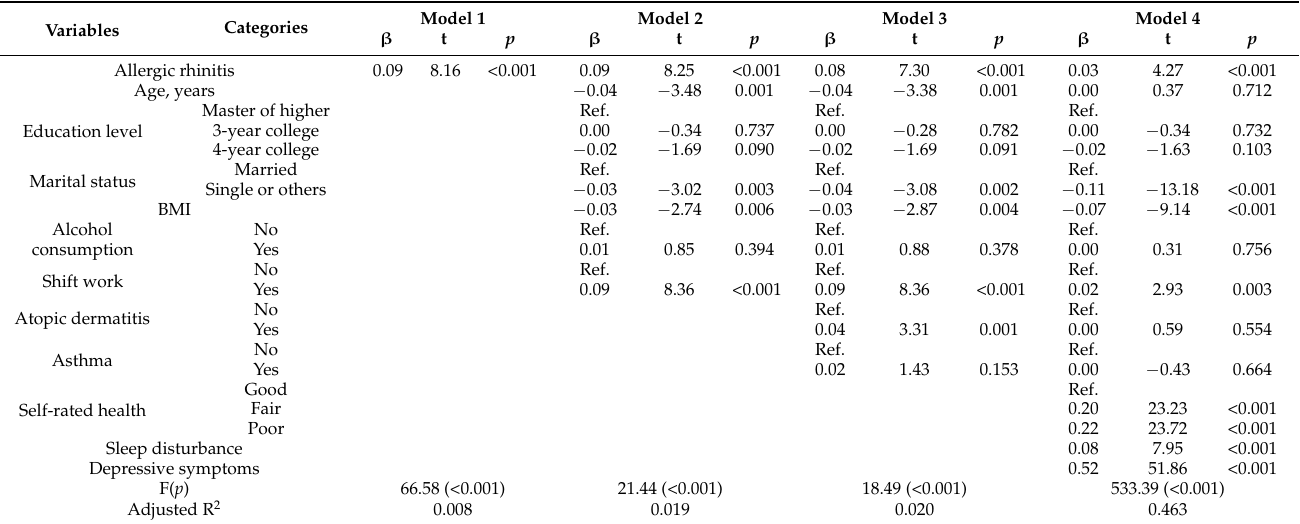
Table 4. Effects of allergic rhinitis on fatigue ( N =